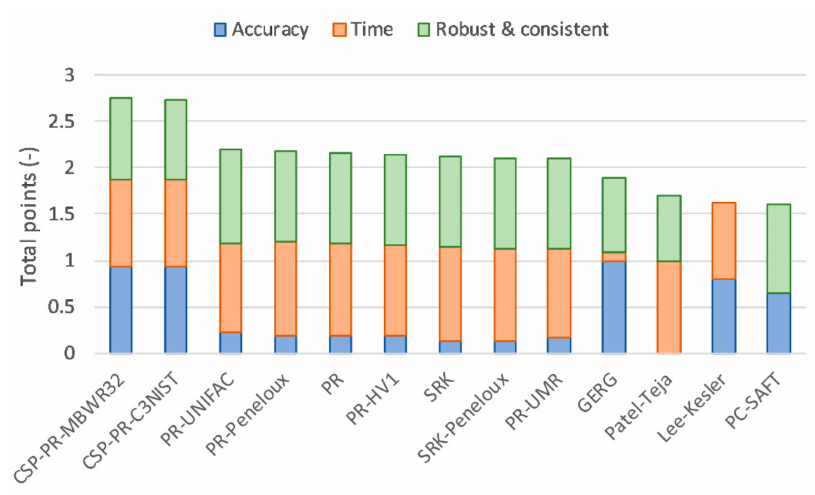
Figure 8. Overall performance of each